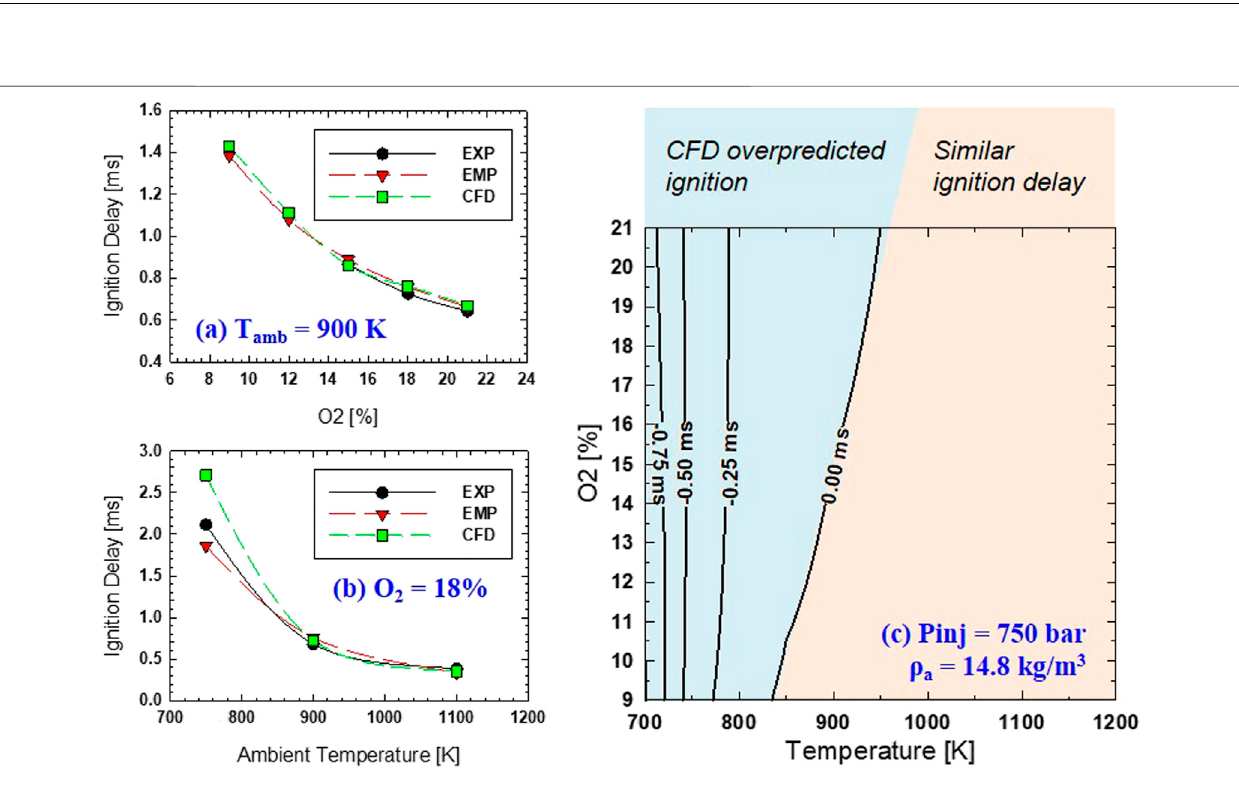
FIGURE 5 | (A) Comparison of ignition delay by experiment (EXP), empirical equation (EMP), and CFD at 900 K, 14.8 kg/m 3, and 75 MPa for different levels of O 2 ; (B) Similar comparison for the various ambient temperature at 14.8 kg/m 3 , 75 MPa, 18% O 2 ; (C) Difference of ignition delay between EXP and CFD over different T amb and O 2 at same condition of 14.8 kg/m 3 and 75